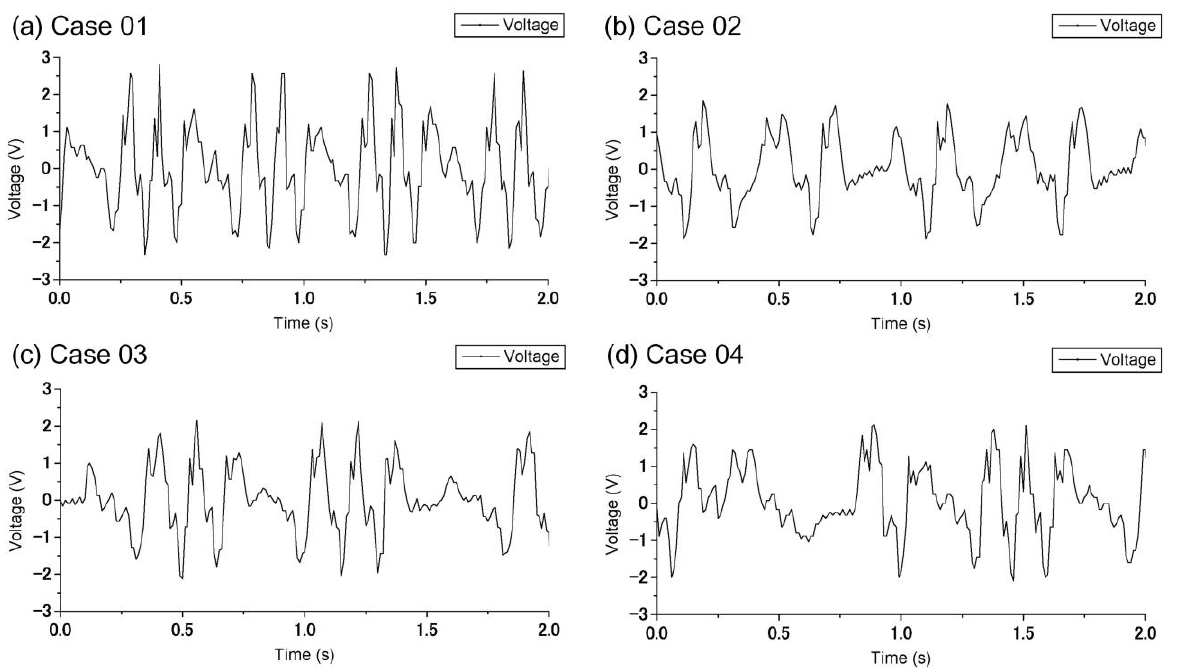
Figure 8. Spectra of the slider and buoy motion as a function of wave frequency in Case 1.